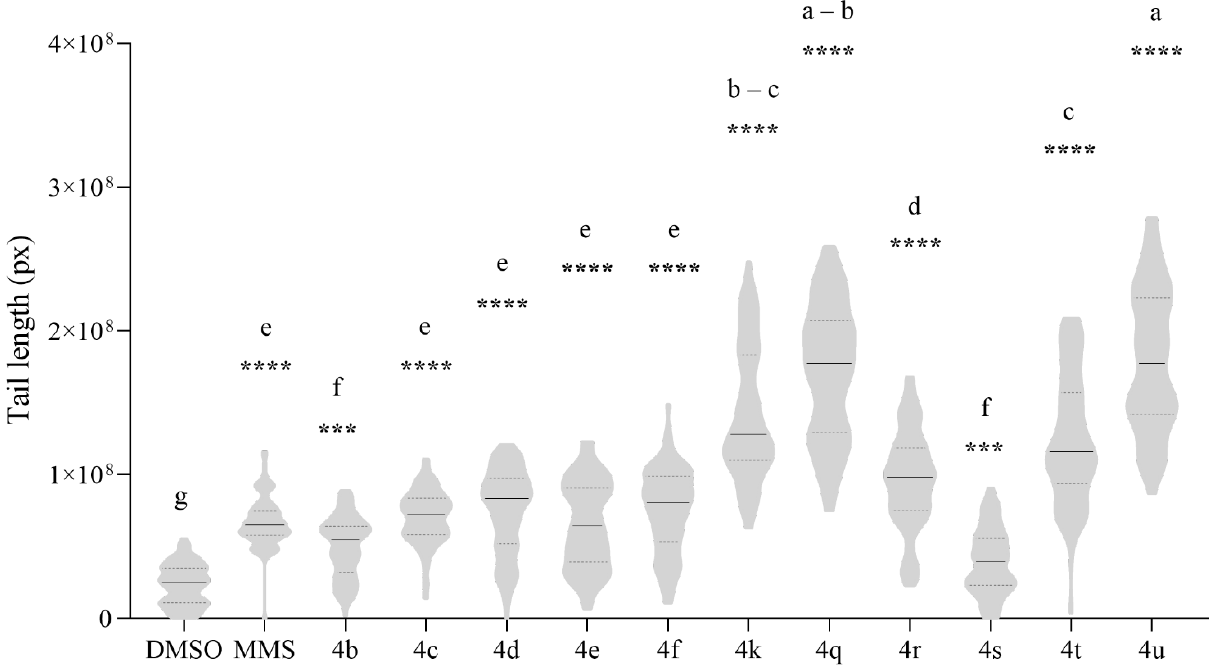
Figure 1. Comet assay of Leishmania mexicana cells exposed to bis(spiropyrazolone)cyclopropanes 4 including Violin plots of tail length measurements from a comet population. Black traits indicate the median and dashed traits including highest and lowest quartiles of each population. DMSO: dimethylsulfoxide; Dox: doxorubicin. The tests for significance were limited to the Kruskal–Wallis one-way ANOVA. Post hoc tests were done via Fisher’s least significant difference. Treatments with the same letter are not significantly different. Significance codes: **** p -value < 0.0001; *** p -value < 0.001.